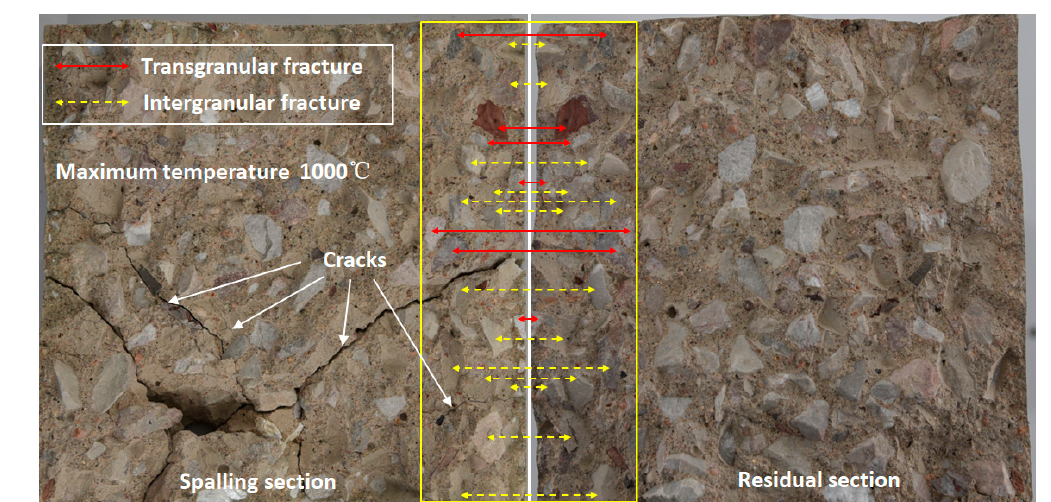
Figure 7. Morphology, structure and composition of fracture surface. (The back of the spalling section is the heated surface).